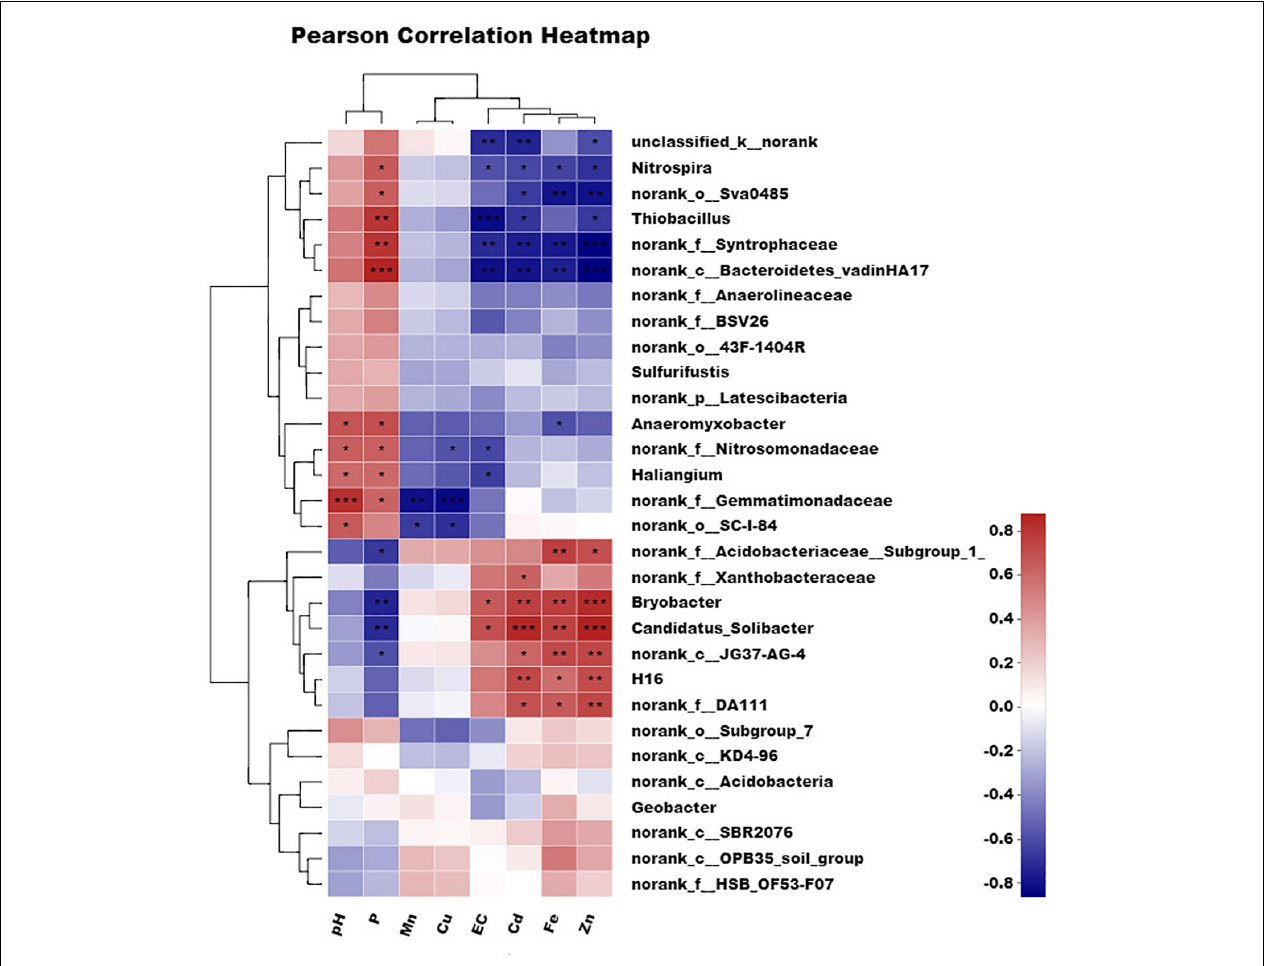
FIGURE 6 | Correlation between different influencing factors and different microorganisms in genus level. Single asterisk (* P < 0.05), double asterisk (** P < 0.01), and three asterisk (*** P ≤ 0.001) indicate statistically significant differences between values.